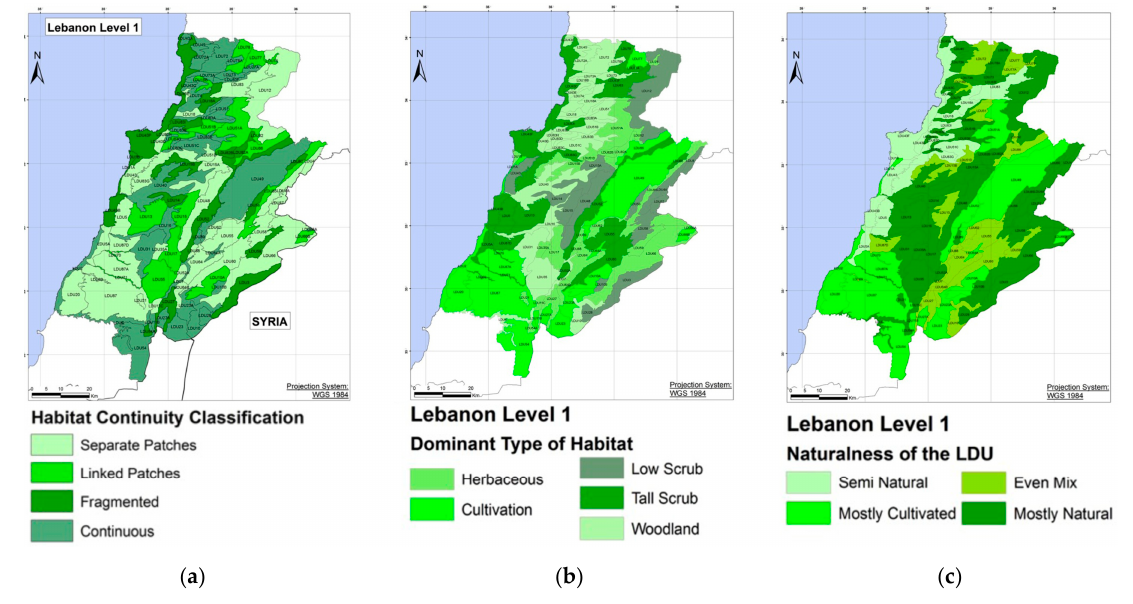
Figure 7. Maps of Lebanon’s habitat continuity ( a ), dominant habitat ( b ), and naturalness ( c ). Table 6. Ranking system of LDUs according to naturalness.